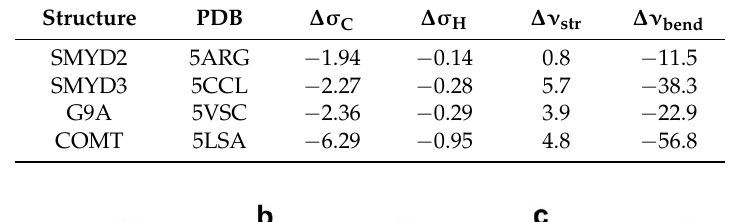
Table 3. Calculated changes in the NMR chemical shift ( ∆ σ , ppm) and the symmetric stretching and bending frequencies ( ∆ ν , cm − 1 ) within the methyl group of MeS + (Et) 2 caused by complexation. Structure PDB ∆ σ C ∆ σ H ∆ ν str ∆ ν bend SMYD2 5ARG